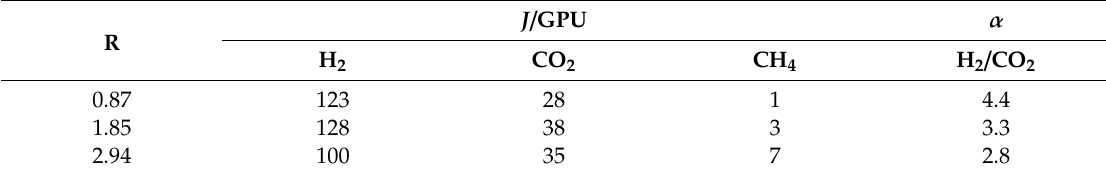
Figure 9. Effects of membrane area ratio on separation performance of dual membrane separator. ( a ) The recovery of H 2 ; ( b ) the purity of H 2 ; ( c ) the recovery of CO 2 ; and ( d ) the purity of CO 2 . Table 2. Performance of PI membranes in the dual membrane separator under different membrane area ratios ( Q F was about 100 mL/min).